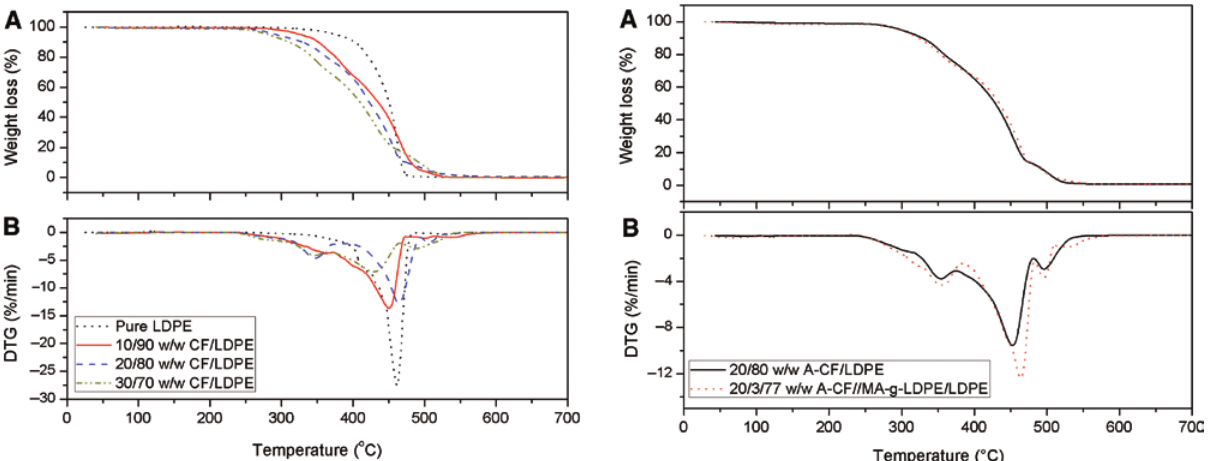
Figure 7: TG (A) and DTG (B) curves of A-CF/LDPE composites at 20 wt% fiber loading with or without